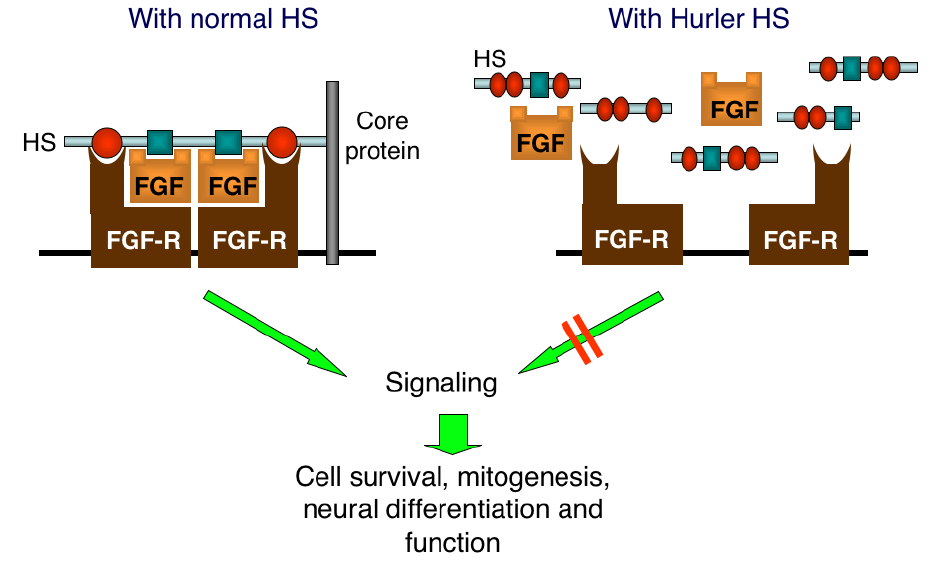
FIGURE 2. Hurler HS fails to mediate formation of the FGF2-FGFR1-HS complex. Normal HS proteoglycans on the cell surface mediate the formation and dimerization of the FGF2-FGFR1-HS complex, leading to the biological effects of FGF2. In contrast, the small, abnormally sulfated HS chains in Hurler syndrome fail to induce formation and dimerization of the FGF2-FGFR1-HS complex, impairing the biological activity of FGF2. The blue boxes and red circles on normal HS chains represent specific sulfated domains of HS required for binding to FGF2 and FGFR; abnormal Hurler HS domains (blue rectangles and red ovals) fail to